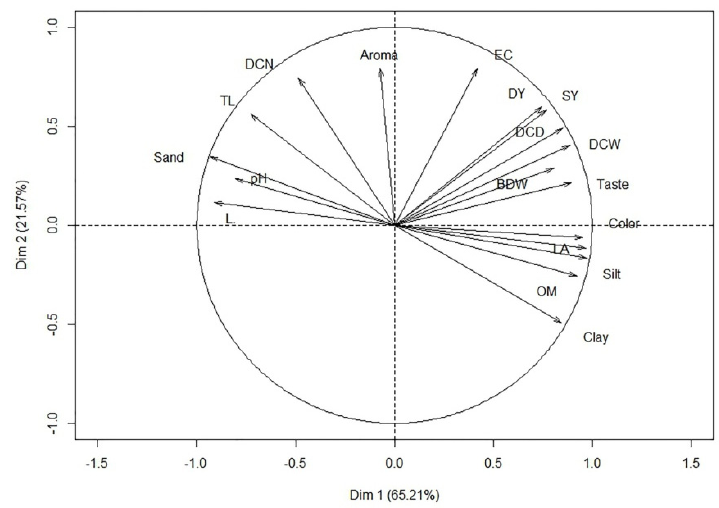
Figure 3. Correlation biplot of the two first principal components variables in the two-dimensional space. TL: Total lime; EC: Electrical conductivity; OM: Organic matter; DY: Daughter corm yield; SY: Stigma yield; DCN: Daughter corm number; DCW: Daughter corm weight; DCD: Daughter corm diameter; BDW: Bioresidues dry weight; LA: Leaf area.